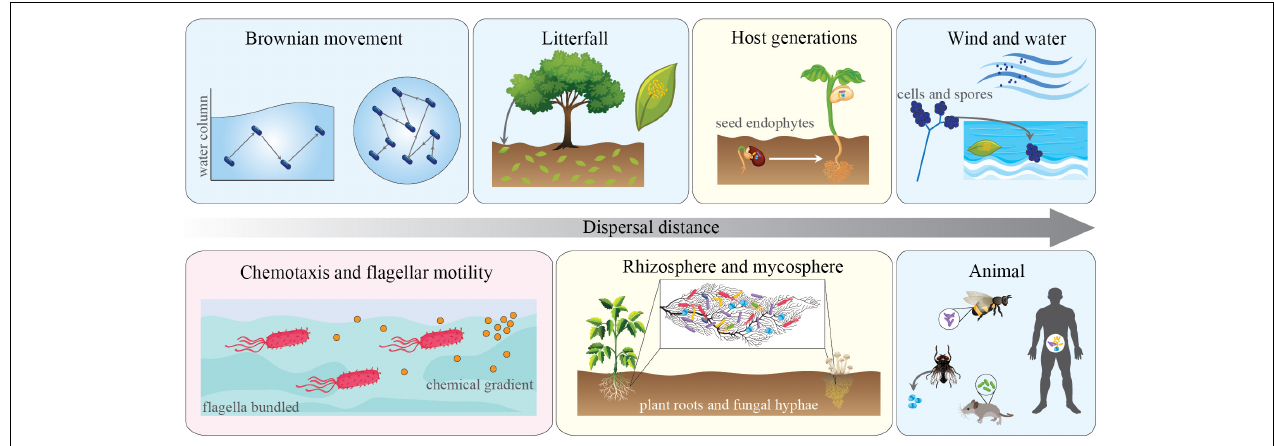
FIGURE 1 | Types and mechanisms of microbial dispersal and the modes by which they operate. Panels depict multiple instances of passive (light blue), active (light red) dispersal. Light yellow panels indicated that both modes of action operate simultaneously. Dispersal range of µ M to upwards of hundreds of kilometers is indicated by the horizontal arrow. The figure includes different habitat types and local hotspots that align with the type and selection of traits associated with dispersal in different contexts (see main